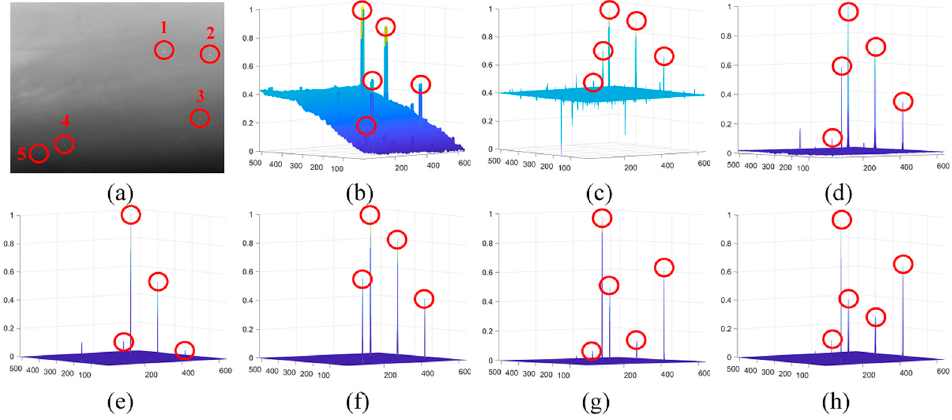
Figure 13. The detection results of different methods on S4: ( a ) the 79th image in S4 and ( b – h ) nor- malized 3-D mesh obtained by the LCM [18], IPI [10], MCPM [19], LIG [22], PSTNN [12], FKRW [15], and the proposed method, respectively.